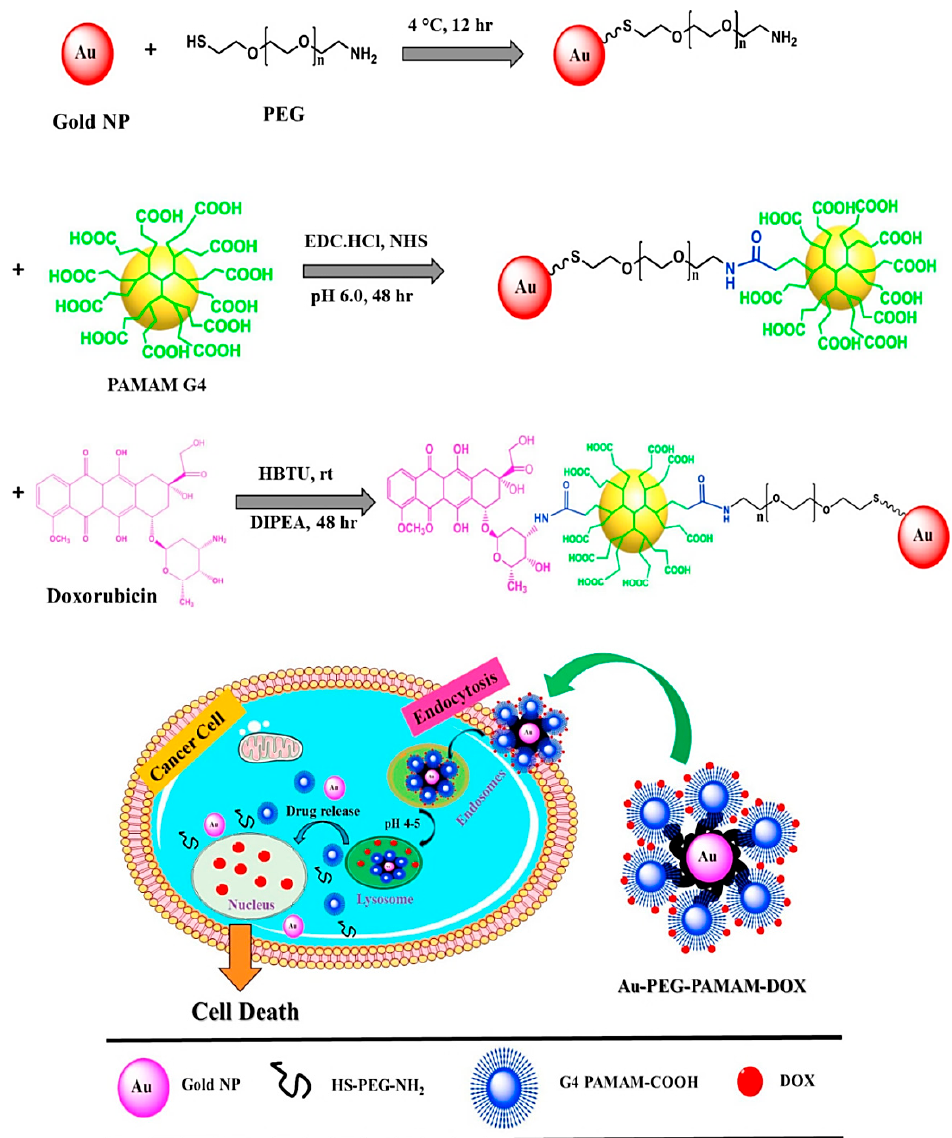
Figure 2. The preparative process and mechanisms of pH-triggered multifunctional nanosystems constructed from Au NPs, polyethylene glycol (PEG), and polyamidoamine (PAMAM) G4 dendrimer for targeted delivery of doxorubicin (DOX). 1-ethyl-3-(3-dimethylaminopropyl) carbodimide (EDC); O-(benzotriazol-1-yl)- N,N,N ′ ,N ′ -tetramethyluronium hexafluorophosphate (HBTU); diisopropyl ethylamine (DIPEA). Adapted from Ref [15] with permission. Copyright 2017 Elsevier.